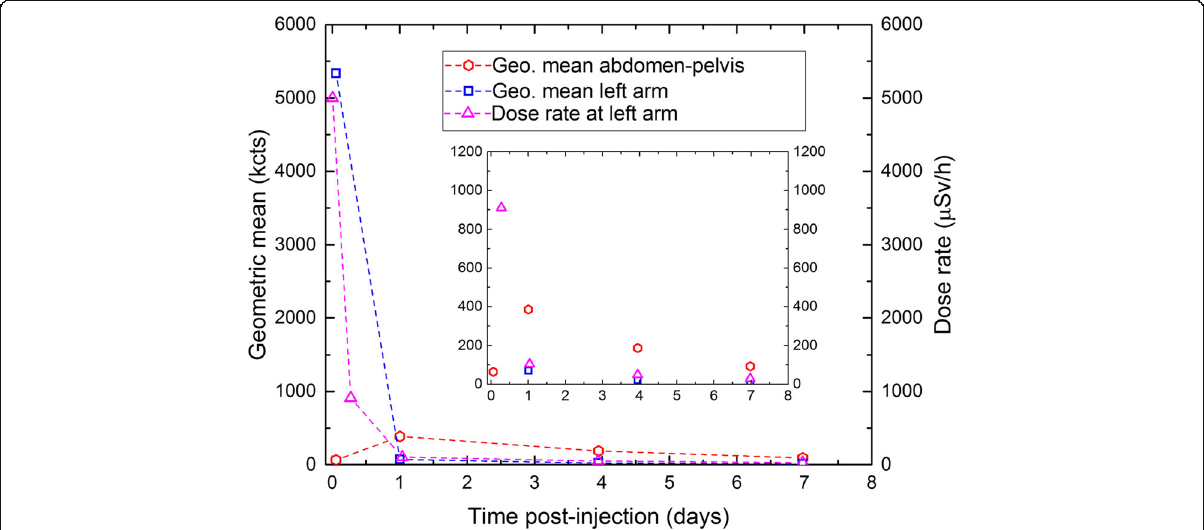
Fig. 3 Geometric mean over the abdominal-pelvic region including liver, spleen, tumors and bladder (red hexagons; background corrected using a region-of-interest in the thorax) and over the left arm (blue squares; background corrected using a region-of-interest in the right arm) with units on the left axis. The dose rate with data from Table 1 is plotted as magenta triangles with units on the right axis (the scales on the left and right axis are the same by coincidence). The dashed lines are intended to guide the eye. The inset shows a zoom of the main graph